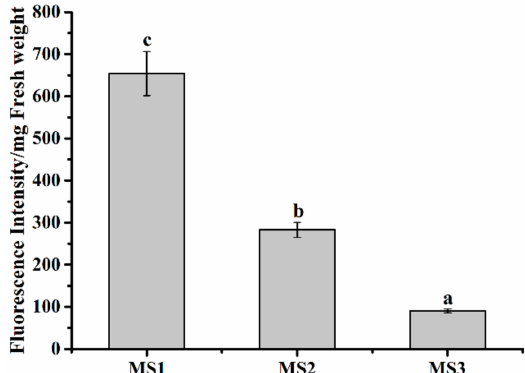
Figure 13. In vivo uptake efficiencies of coumarin 6-loaded azoxystrobin microspheres against Colletotrichum higginsianum Sacc. For coumarin 6 fluorescent values, different lowercase letters indicated statistically significant differences (one-way ANOVA, SNK test, p <